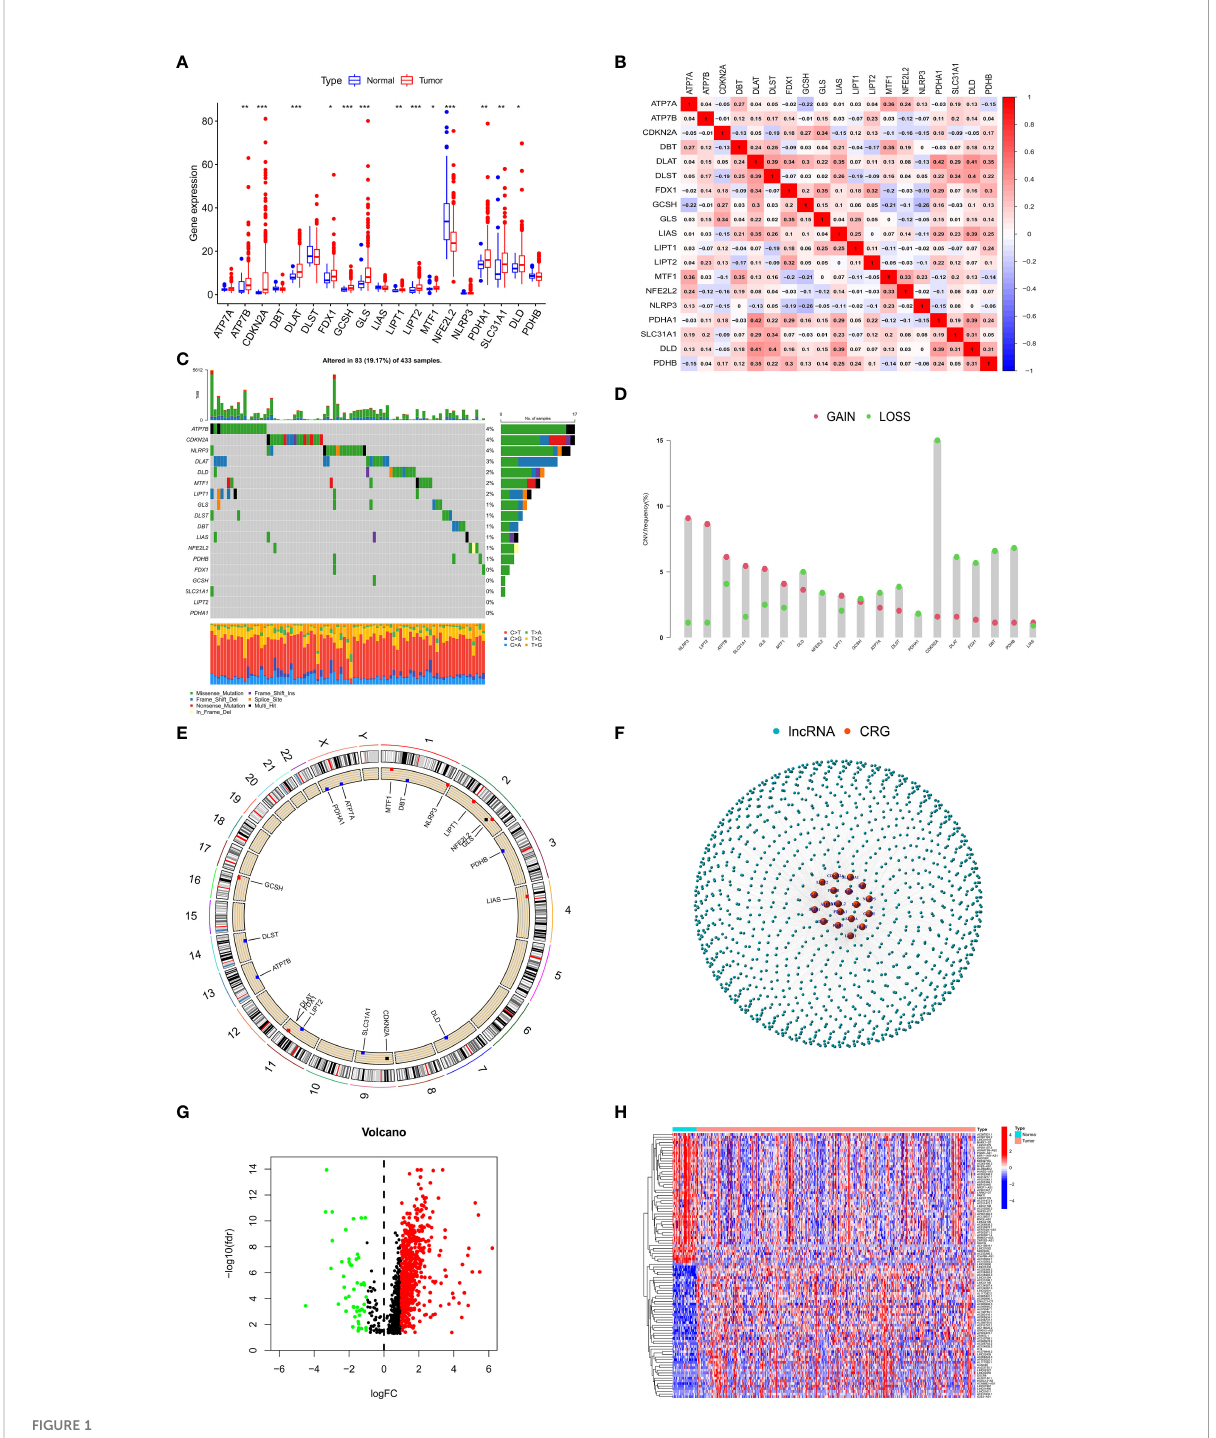
FIGURE 1 Landscape of CRGs and identi fi cation of CRLs in GC patients. (A) The expression of 19 CRGs in GC and normal tissues. (B) Correlation analysis of 19 CRGs. (C) The mutation frequency of 19 CRGs in STAD. (D) The CNV variation frequency of 19 CRGs in STAD. (E) The location of CNV alteration of 19 CRGs on 23 chromosomes in STAD. (F) Gene coexpression network map of CRGs and lncRNAs. (G) Volcano plot shows differentially expressed CRLs. (H) Heatmap showed the top 50 differentially expressed CRLs. *p < 0.05, **p < 0.01, and ***p <